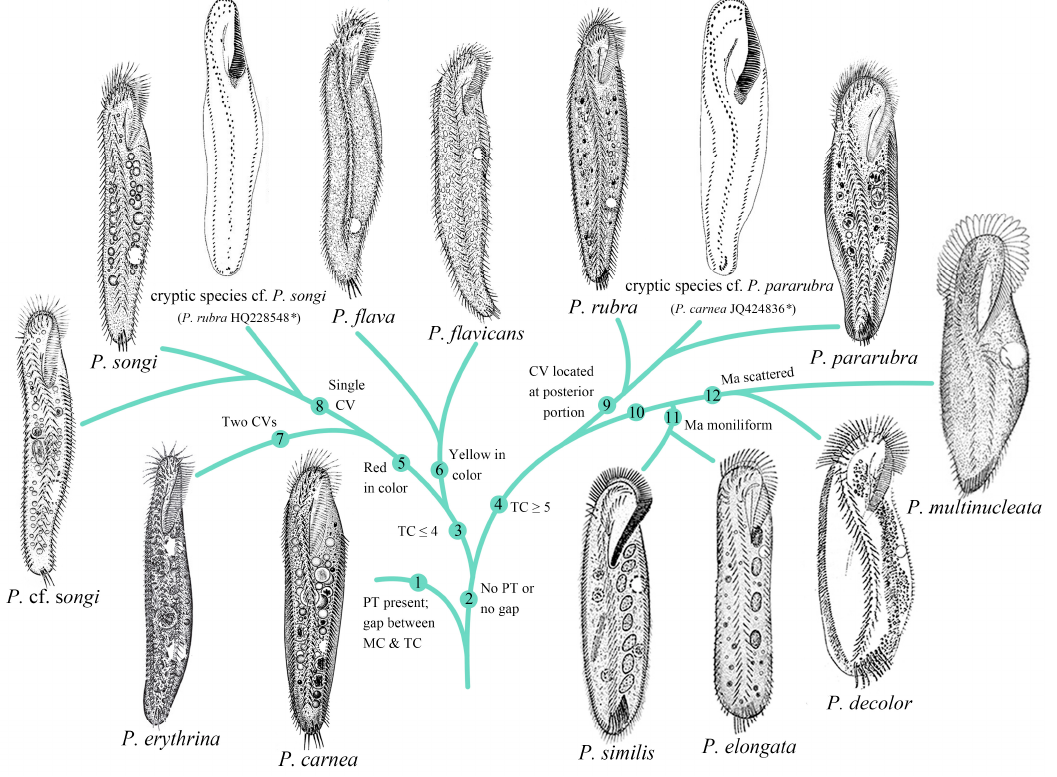
Figure 10. Putative phylogenetic relationships of all available Pseudokeronopsis species. *, previously misidentified species. Synapomorphies of major clades were numbered. The number 10 indicates the feature that contractile vacuole is located at mid-body or the anterior portion of body. CV, contractile vacuole; Ma, macronuclear nodules; MC, midventral complex; PT, pretransverse cirri; TC, transverse cirri.